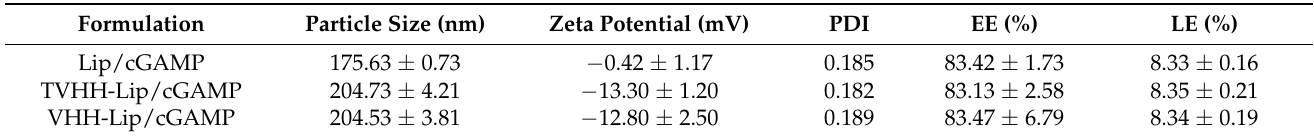
Table 1. The characterization of cGAMP-loaded liposomes.